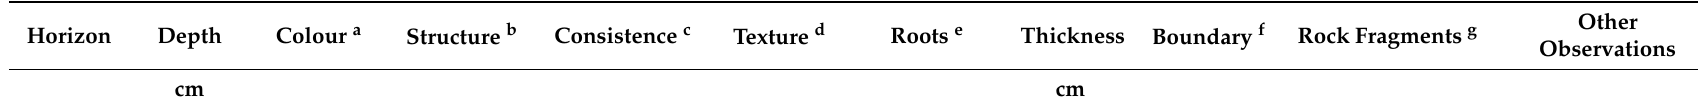
Table A1. Main descriptive elements of soil profiles developed under the broadleaf forests and the areas reforested with black pine ( Pinus nigra J.F. Arnold) at 500, 700 and 1000 m a.s.l., Mount Cucco massif (Central Apennines, Italy). For symbols see legend. Horizon Depth Colour a Structure b Consistence c Texture d Roots e Thickness Boundary f Rock Fragments g